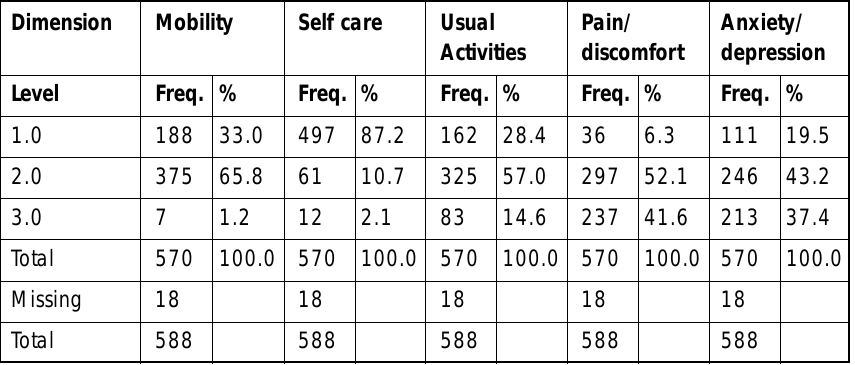
Table 2: Health status of the subjects (n=588) Dimension Mobility Self care Usual Pain/ Anxiety/ Activities discomfort depression Level Freq. % Freq. % Freq.